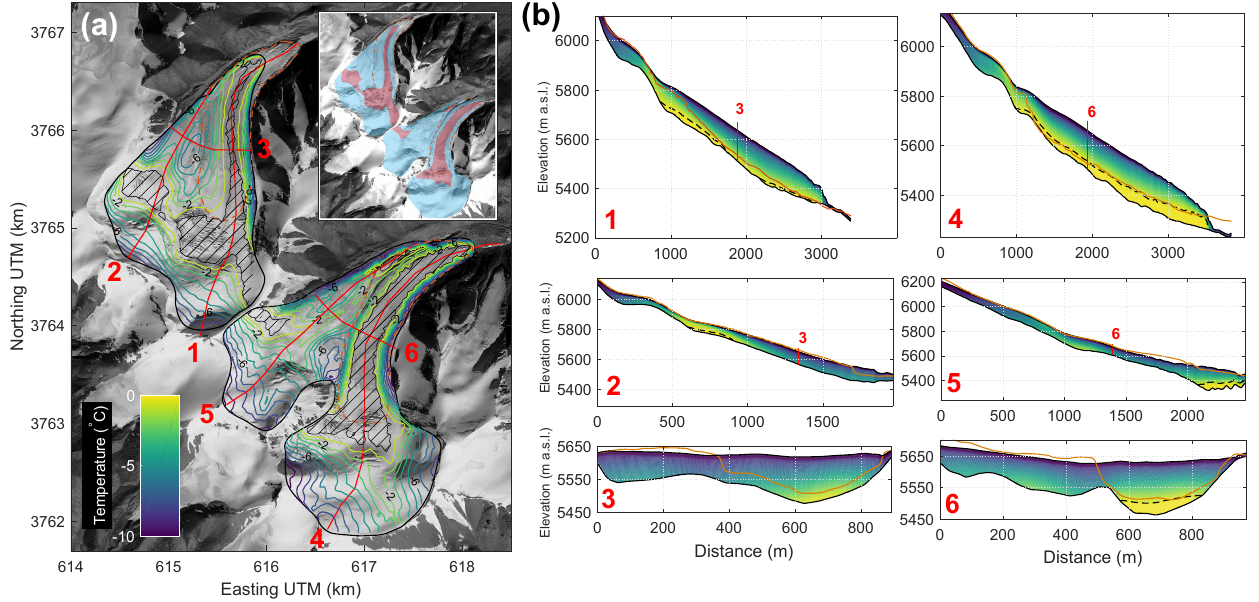
Figure 5. Modelled steady-state temperature on the Aru-1 and Aru-2 glaciers. Left panel shows basal temperature with black hatched lines showing temperate areas. The inset highlights temperate-based (red) and cold-based (blue) areas. Orange dashed lines indicate the detachment outline. Panel (b) shows 2-D temperature profiles 1 to 6 as indicated in panel (a) (red lines). Profiles include Pléiades 2016 elevation profiles (orange lines). The dashed black lines indicate the cold-temperate transition surface. Note that vertical scale is exaggerated in profiles 1 and 4.